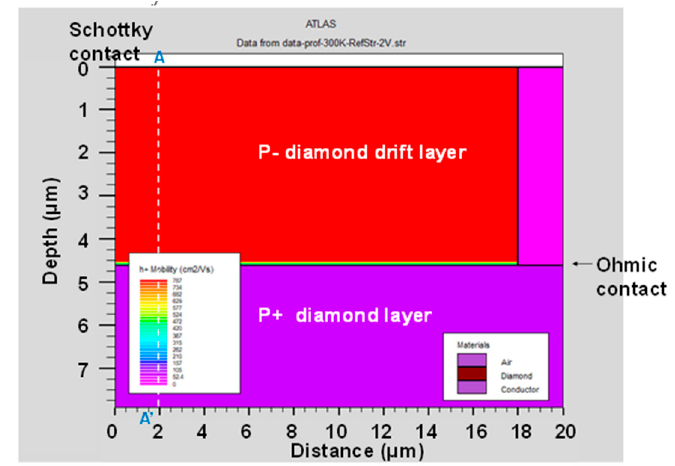
Figure 5. Hole mobility of the p-type diamond pseudo-vertical Schottky barrier diode (SBD) simulated using the analytic mobility model. The anode voltage ( V a ) was 2 V at 300 K.